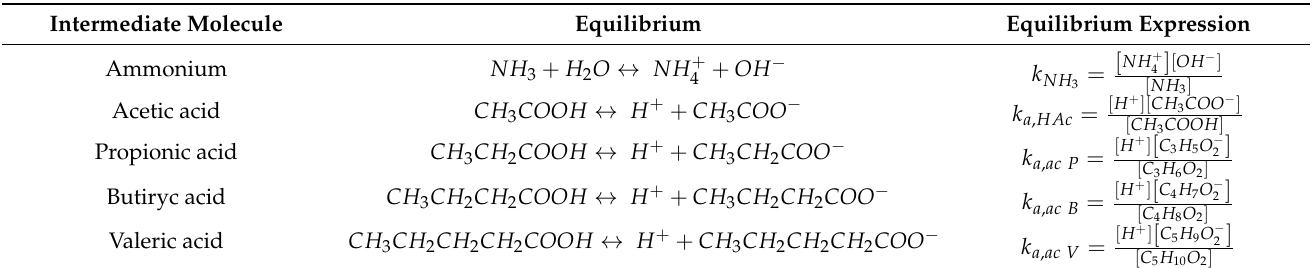
Table 2. Acid/base equilibrium reactions included in the model to calculate the